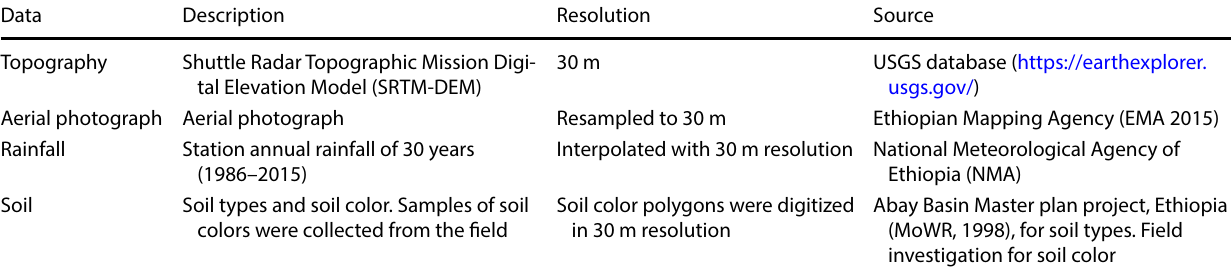
Table 1 Data and data sources used in the study Data